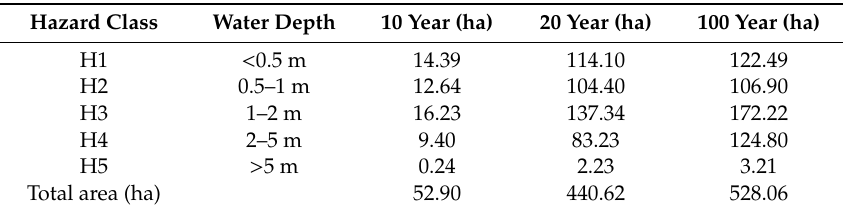
Table 6. Areas a ff ected by the floods of di ff erent return periods for the settlement Zhibek Zholy (Classification